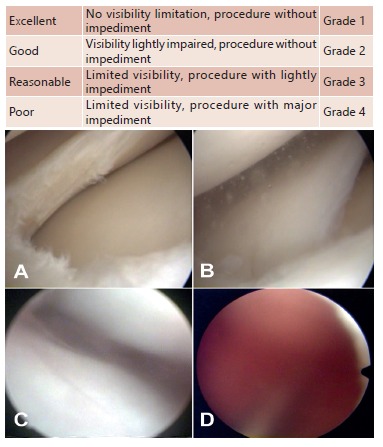
Arthroscopic visibility classification
10
: A) grade 1; B) grade 2; C) grade 3; D) grade 4